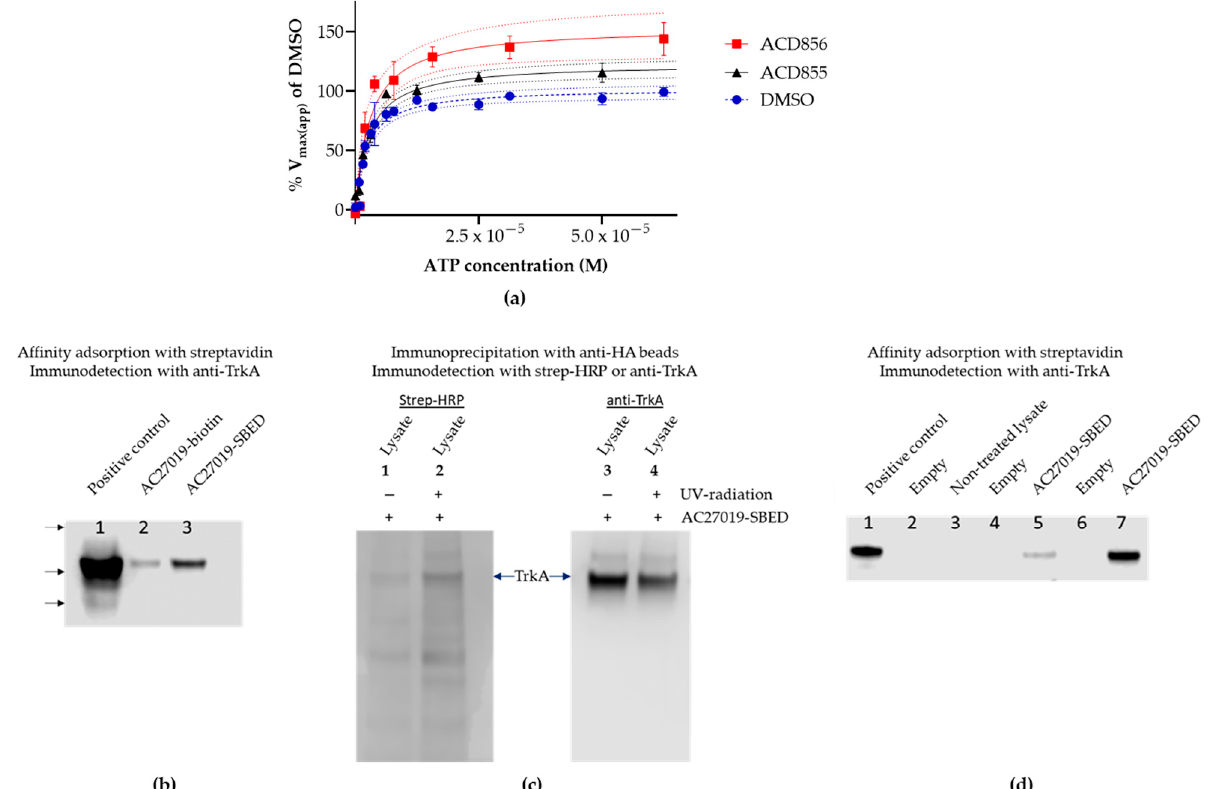
Figure 3. Mechanism of action of triazinetriones on TrkA. ( a ) Full-length TrkA with a HA-tag (TrkA-HA) fused to the C -terminus was purified through immunoprecipitation using anti-HA agarose beads. Purified TrkA-HA was incubated with DMSO (blue circles and hatched line), ACD855 (5 µ M) (black triangles and solid line), or ACD856 (1 µ M) (red squares and solid line) for approx. 5 min. Thereafter, ATP was added to yield the indicated concentration. Each data point is the mean ± SEM ( n = 3). The solid lines are the curve-fit using the Michaelis–Menten equation used to calculate the apparent Vmax(app) and km(app), and the dotted lines are the 95% confidence band for each curve fit. ( b – d ) Affinity labeling and streptavidin adsorption of Trka. ( b ) Western blot of streptavidin adsorbed TrkA-HA non-covalent labeled with NHS-biotinylated triazinetrione compound (lane 2) or covalent labeled by UV-crosslinking of 100 µ M sulfo-SBED biotinylated compound (lane 3). Detection of immunoreactive band was performed with anti-TrkA antibody. Supernatant loaded to the left (lane 1) was used as positive control for the Western blot. Arrows on the left indicate the migration of molecular weight markers corresponding to 198, 98, and 62 kDa. ( c ) Anti-HA agarose immunoprecipitation of cross-linked or non-crosslinked sulfo-SBED compound (AC27019-SBED) from cell lysate incubated with 100 µ M AC27019-SBED. Lane 1, non-UV-crosslinking, and lane 2, UV-crosslinking of sulfo-SBED labeled TrkA-HA, both detected with streptavidin-HRP. Lanes 3 and 4 are loading controls of lanes 1 and 2, respectively, were TrkA-HA was detected by immunoblotting using the anti-TrkA antibody. Both blots were part of the same gel, but the membrane was cut in two pieces, and the proteins were detected by streptavidin-HRP (left panel) or by an anti-TrkA antibody (right panel). ( d ) Streptavidin adsorption of biotinylated compound bound to TrkA-HA. Lane 1, cell lysate used for positive control of immunodetection; lane 3, cell lysate without biotinylated compound was adsorbed to streptavidin-agarose as negative control; lanes 5 and 7, cell lysates containing sulfo-SBED compound UV-crosslinked to TrkA (from two different experiments) were adsorbed to streptavidin- agarose and immunoblotted using anti-TrkA antibody. Lanes 2, 4, and 6 are empty lanes to avoid cross-contamination between